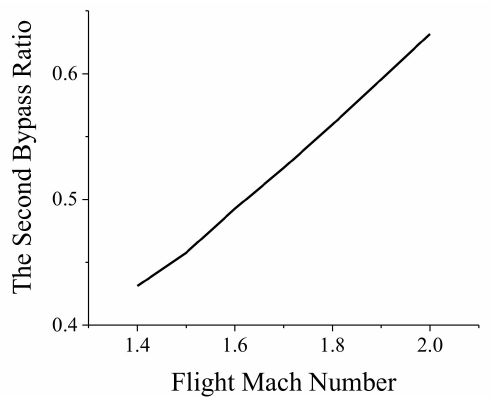
Figure 12. The Second Bypass Ratio vs. Flight Mach Number (Mode 2 with afterburning).